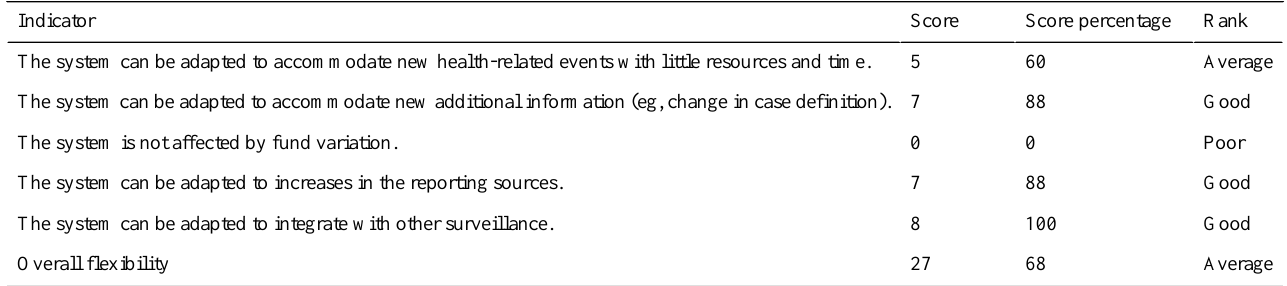
Table 2. The score, score percentage, and rank of flexibility indicators of the Neonatal Tetanus Surveillance System in Sana’a, 2018 (n=8).